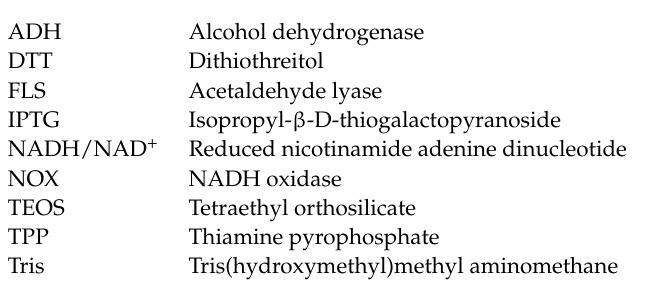
Figure 6. The reusability of the immobilized cascade enzymes.